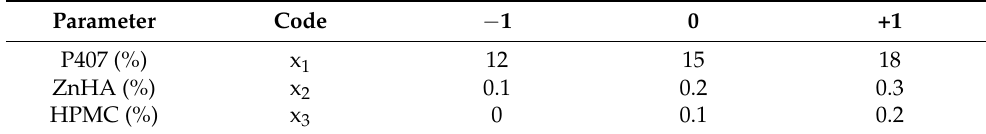
Table 1. Values and levels of the independent